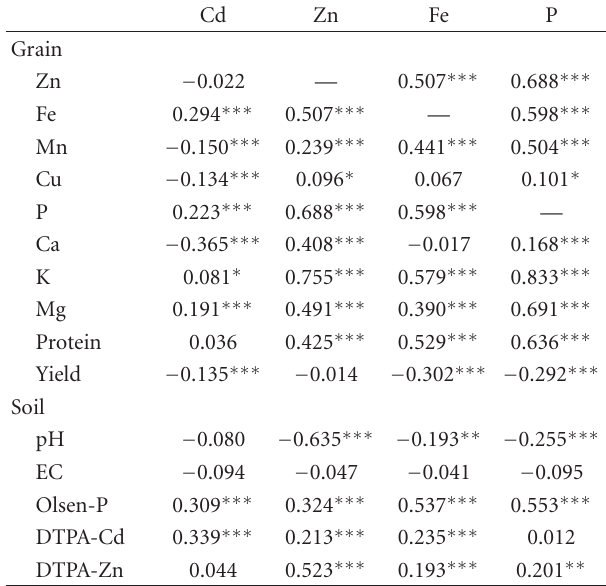
Table 6: Correlation coe ffi cients ( r ) of grain concentrations of Cd, Zn, Fe and P to other elements concentrations, grain yield, grain protein concentration, and soil characteristics (The full dataset is presented in Supplementary Table